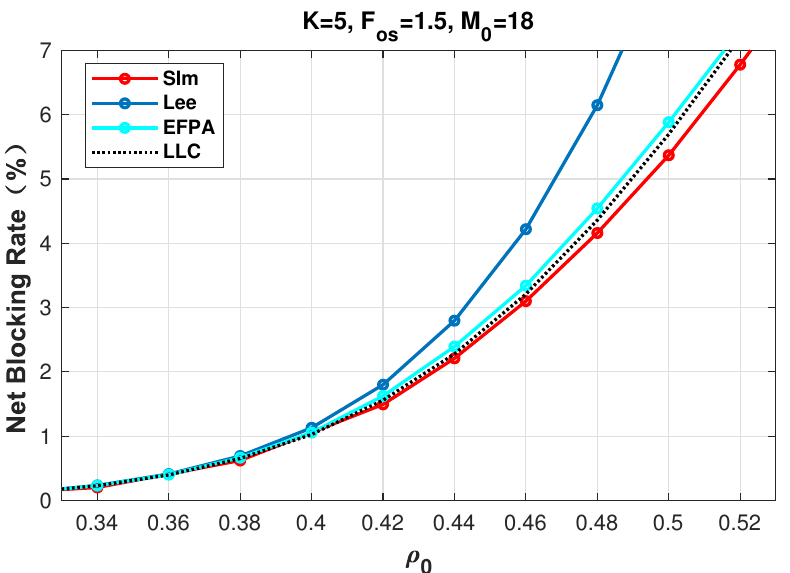
Figure 11. Network blocking performance of different methods with K = 5, F OS = 1.5, and M 0 = 18.